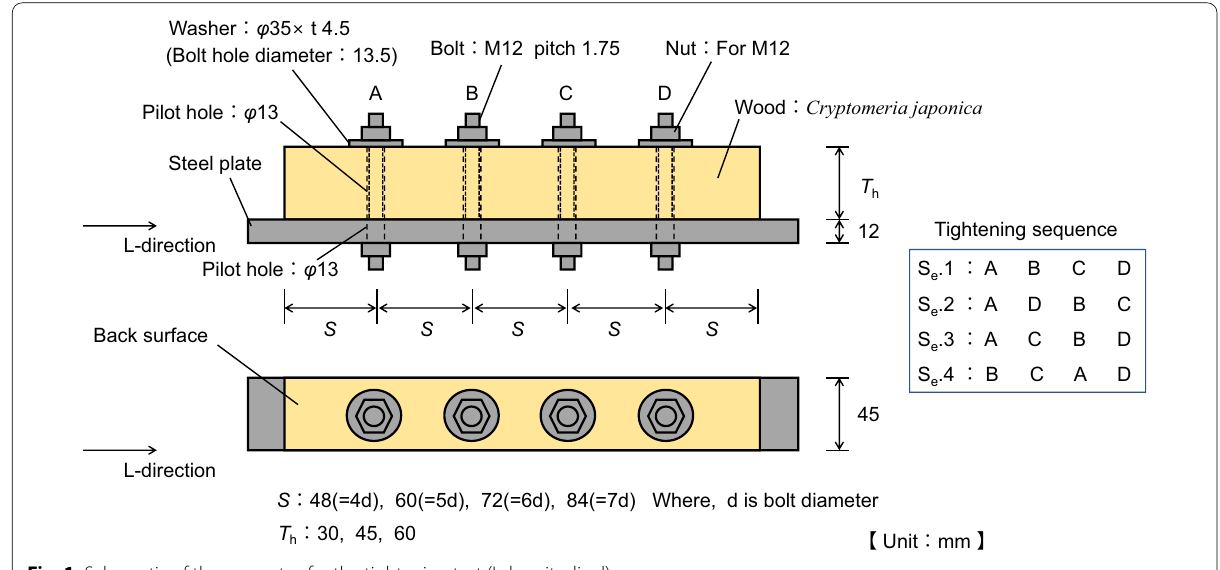
Fig. 1 Schematic of the apparatus for the tightening test (L: longitudinal)